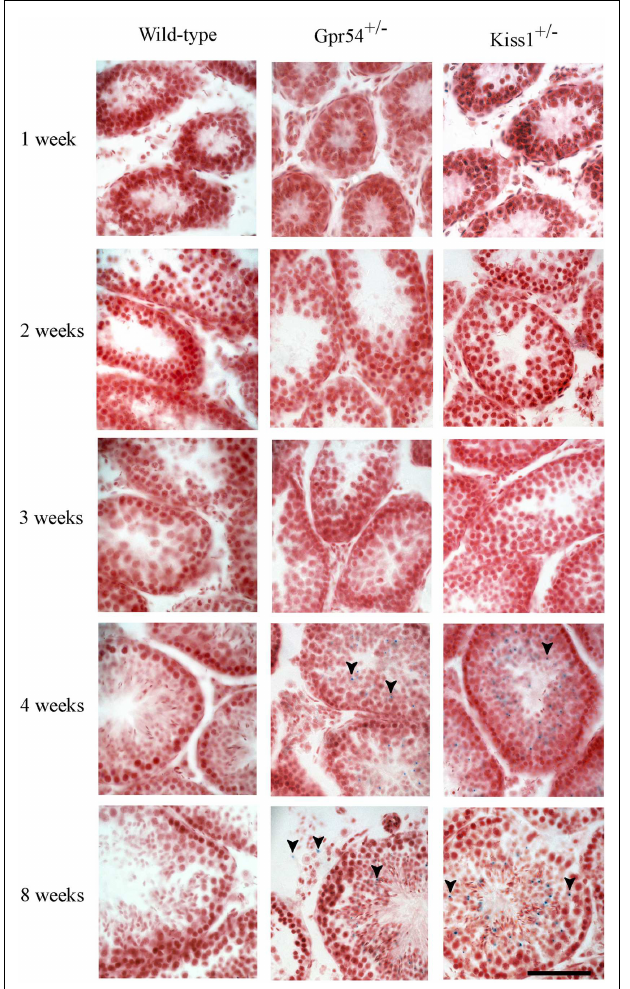
FIGURE 2 | Developmental time course of Gpr54 and Kiss1 expression in the mouse testes .Testes of wild-type (WT), Kiss1 + / − and Gpr54 + / − mice at different ages were cryosectioned, stained for β -galactosidase activity, and counterstained with Saffronin. Blue dots (arrowed) indicate expression of the Kiss1 and Gpr54 genes. All photographs are at the same magnification. Scale bar = 50 µ m.